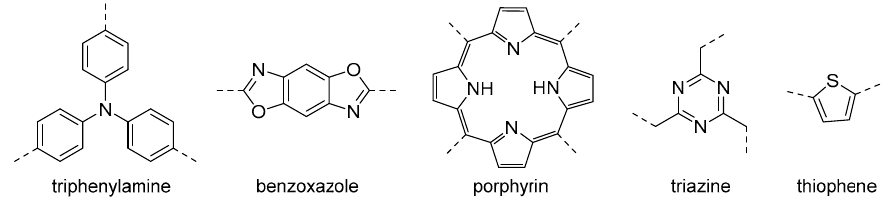
Figure 7. Photoactive incorporated linkers in pristine COFs.